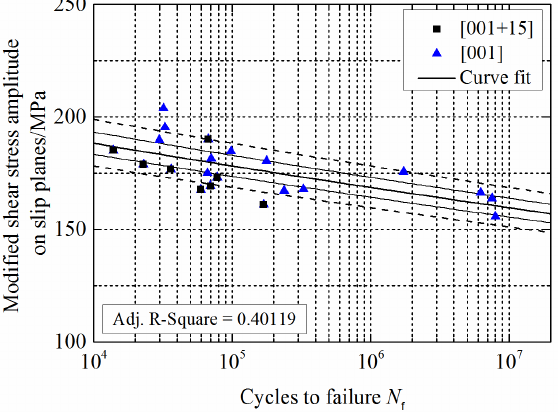
Figure 9. Fatigue life prediction for PWA1484 material at 593 °C using the proposed model.